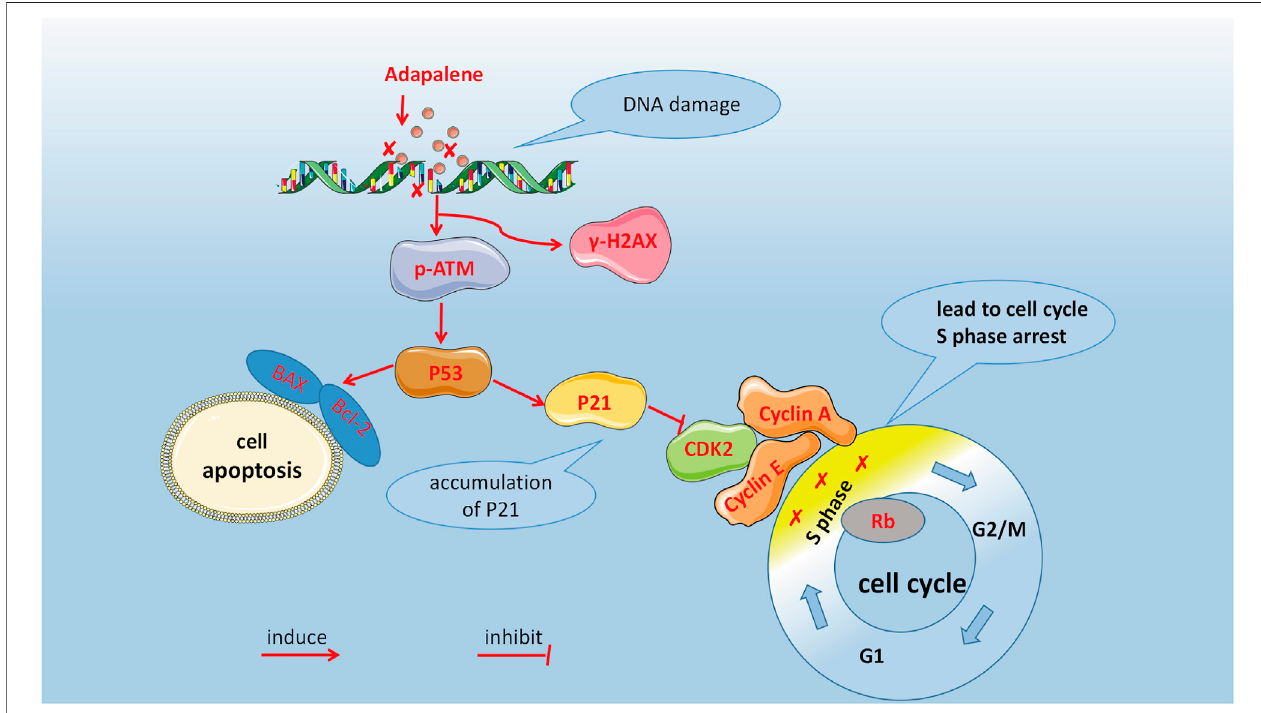
FIGURE 8 | Anticancer mechanism of ADA in RM-1